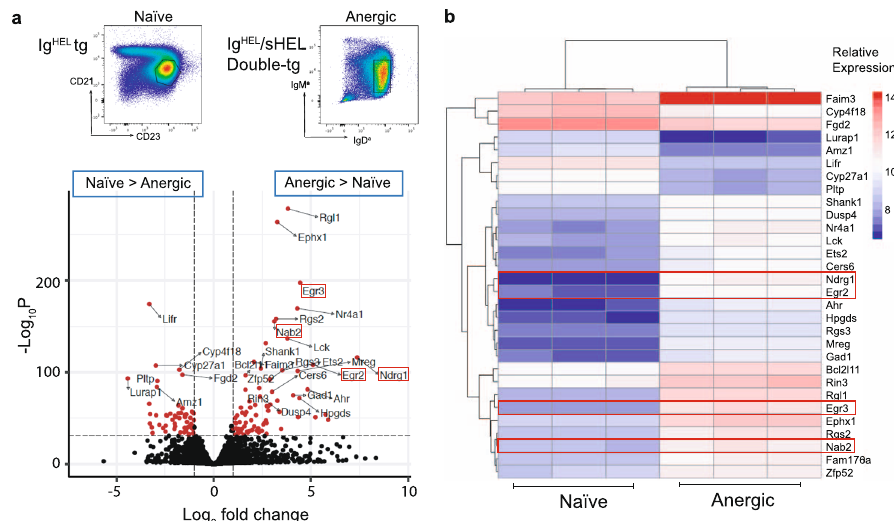
Fig. 1 Ndrg1 is associated with B cell anergy. a Top panel: differential geneexpressionbetween Ig HEL naïve follicular (B220 + CD19 + IgMa + CD93 − CD21 mid CD23 hi ) and Ig HEL /sHEL anergic (B220 + IgMa lo IgDa + ) splenic B cell populations, represented in FACS plots. Lower Panel: Genes differentially expressed >1 and < − 1 log 2 fold change(FC)andbelowasigni fi cancethresholdofadjusted p value,10e − 32,areshowninred,withthetop30differentiallyexpressedgenes fi lteredbyadjusted p value labeled. b Heatmap of the relative abundance of the top 30 differentially expressed genes by adjusted p value between naïve (left) and anergic (right) B cells. Columns represent samples from individual mice.